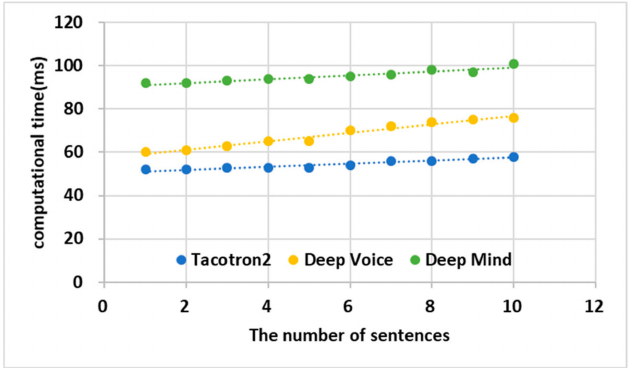
Figure 13. Performance analysis of